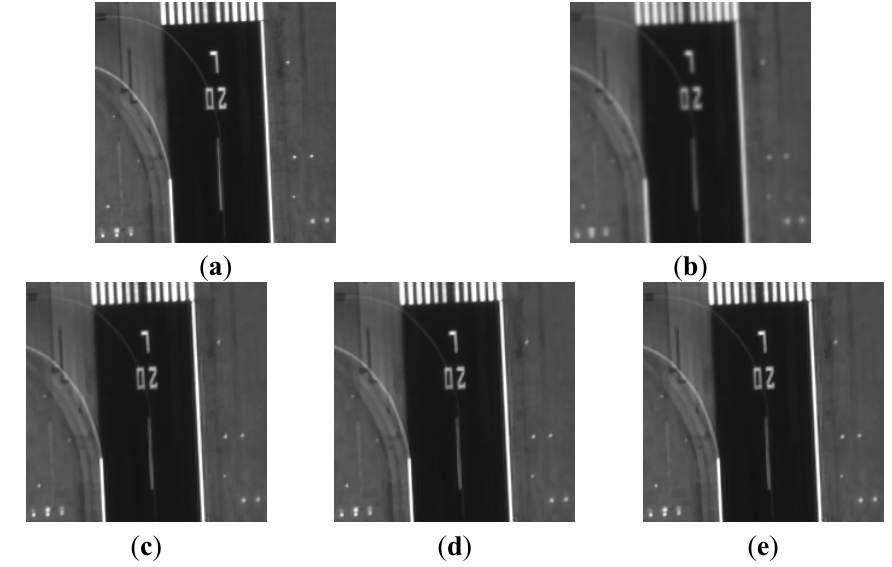
Figure 7. Experimental results of different resolution enhancement methods with Image2. ( a ) Original HR image; ( b ) bilinear interpolation; ( c ) general algorithm (GEN); ( d ) angle weighted (ANGW); ( e ) residual error weighted (RESW).